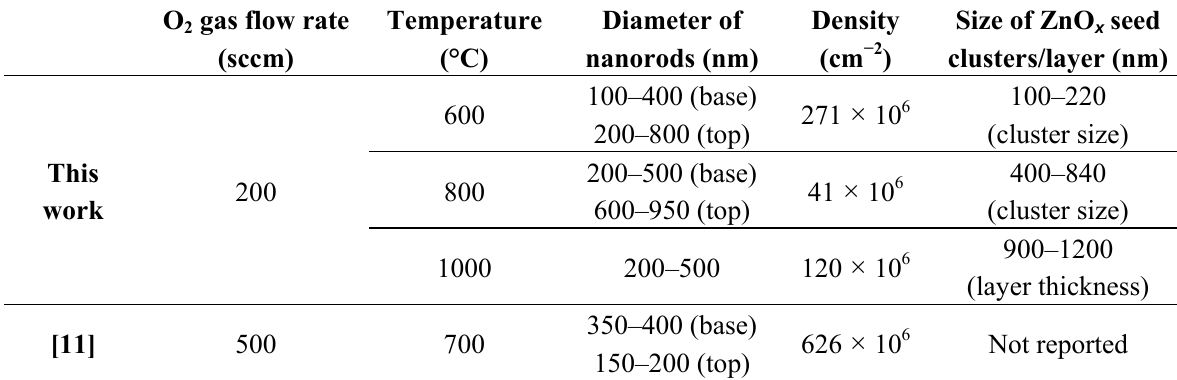
Table 1. Diameter and density of the grown ZnO